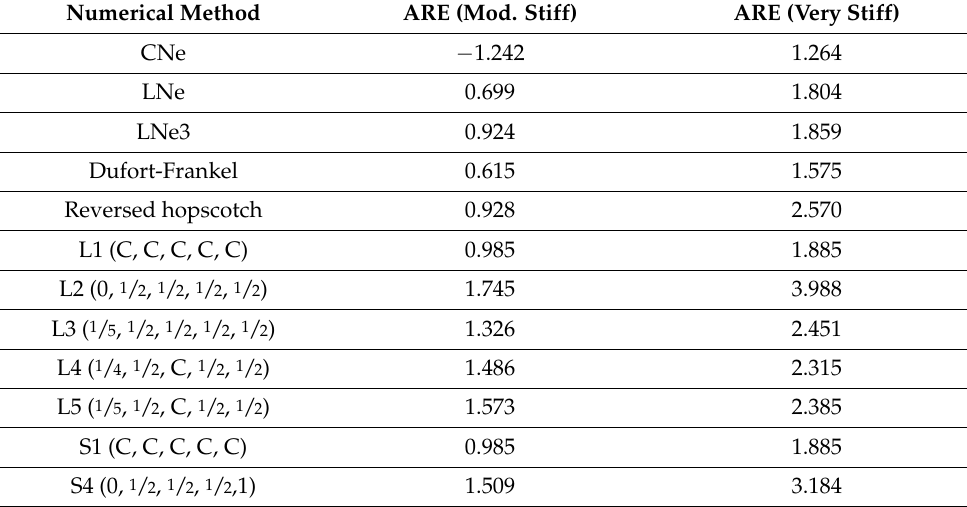
Table 3. ARE (average relative error) quantities of different explicit stable